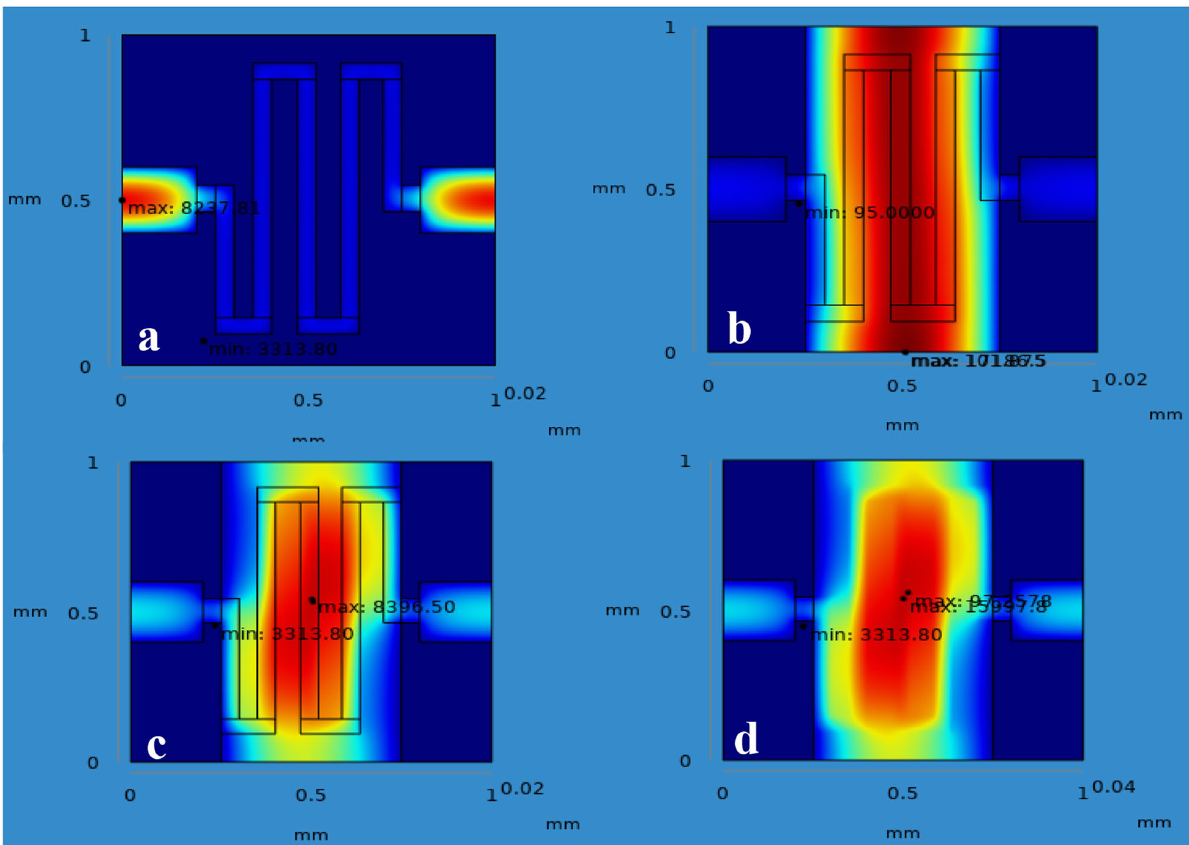
Figure 13. Isothermal contour distribution due to temperature on the thin film chemical gas sensor: ( a ) SnO 2 , ( b )